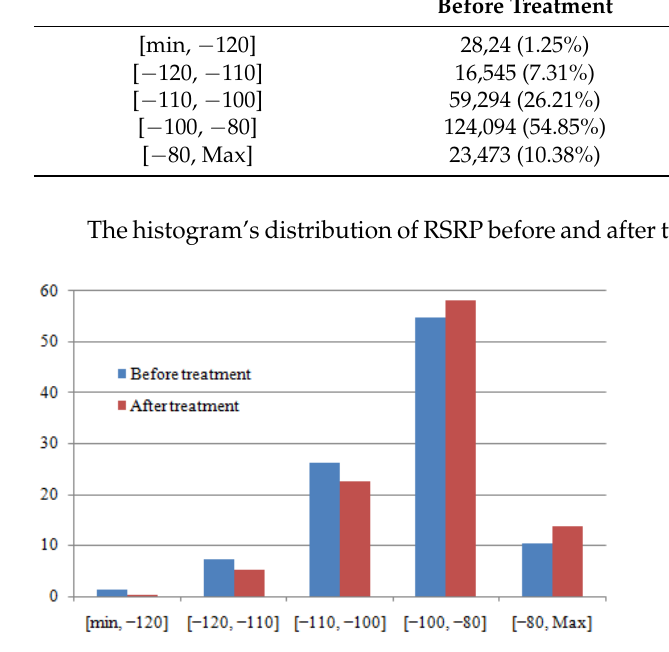
Figure 8. Histogram’s distribution of RSRP (before and after treatment).